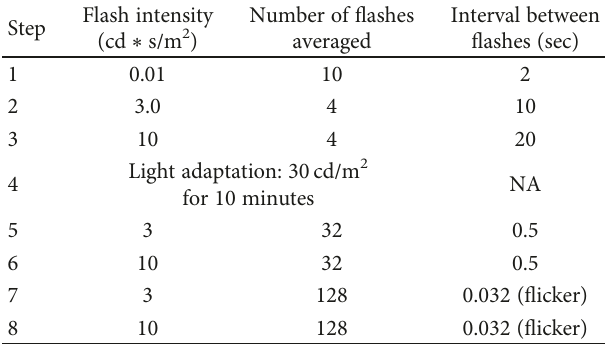
Table 1: ERG protocol